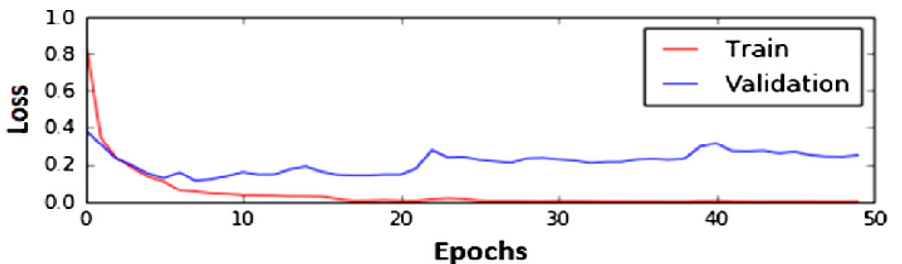
Figure 12. Training and validation accuracy .